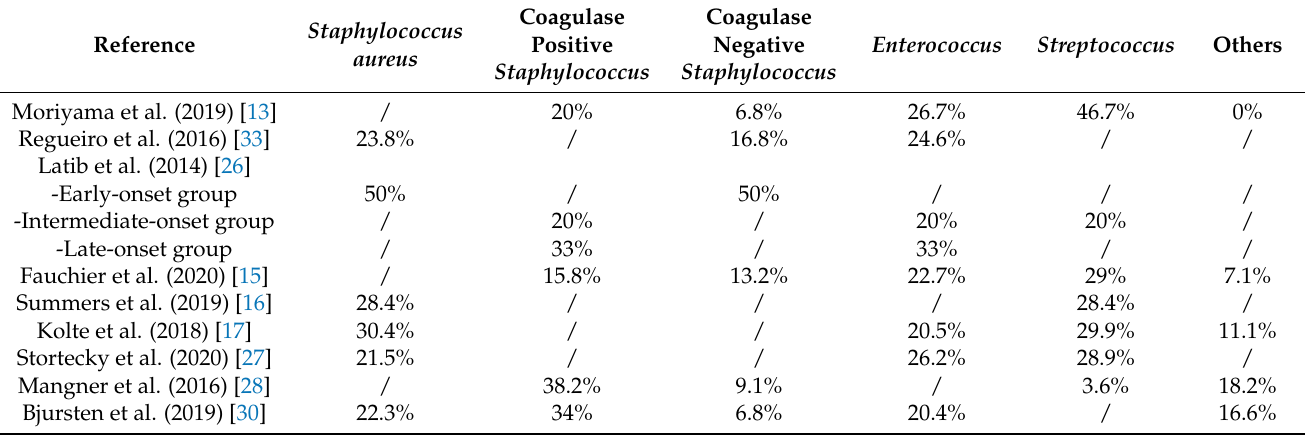
Table 4. Characteristics of the main studies dealing with infective endocarditis in transcatheter aortic valve replacement